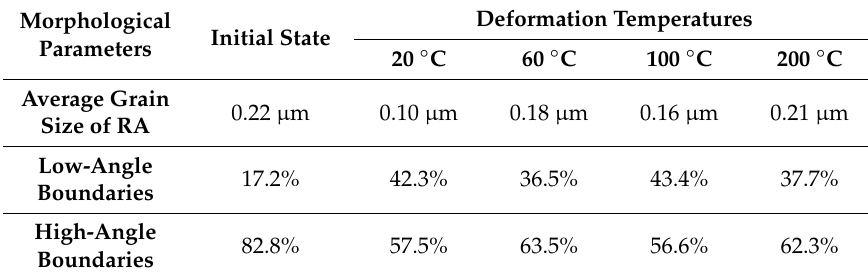
Figure 3. Distribution of misorientation angles in the initial state.